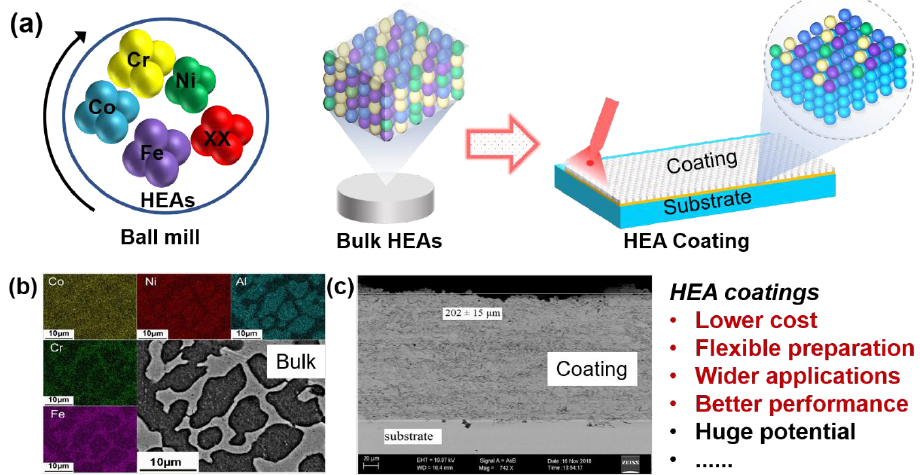
Figure 1. Bulk HEAs and HEA coating. ( a ) Schematic of bulk HEAs and HEA coatings. ( b ) EDS map of Al-Co-Cr-Fe-Ni bulk HEA [ 27 ] . Copyright 2021 Elsevier. ( c ) Cross-sectional back scattered micrograph of the FeCoCrNi 2 Al HEA-coated steel [ 28 ] . Copyright 2019 Elsevier.